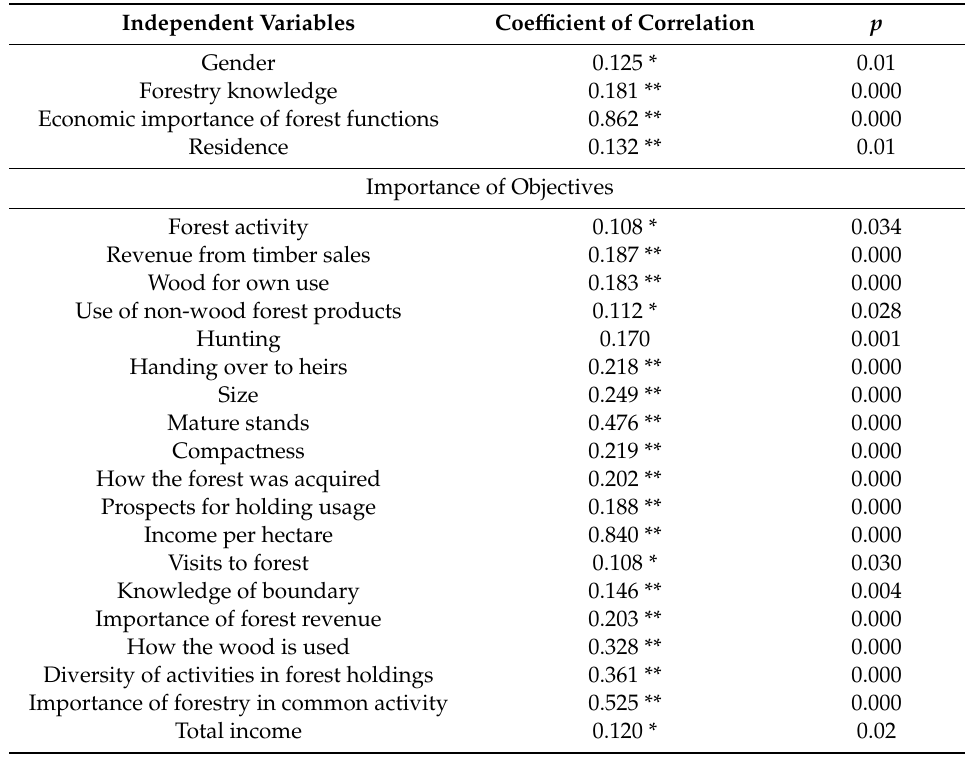
Table 4. Correlations between holdings’ sustainability and independent